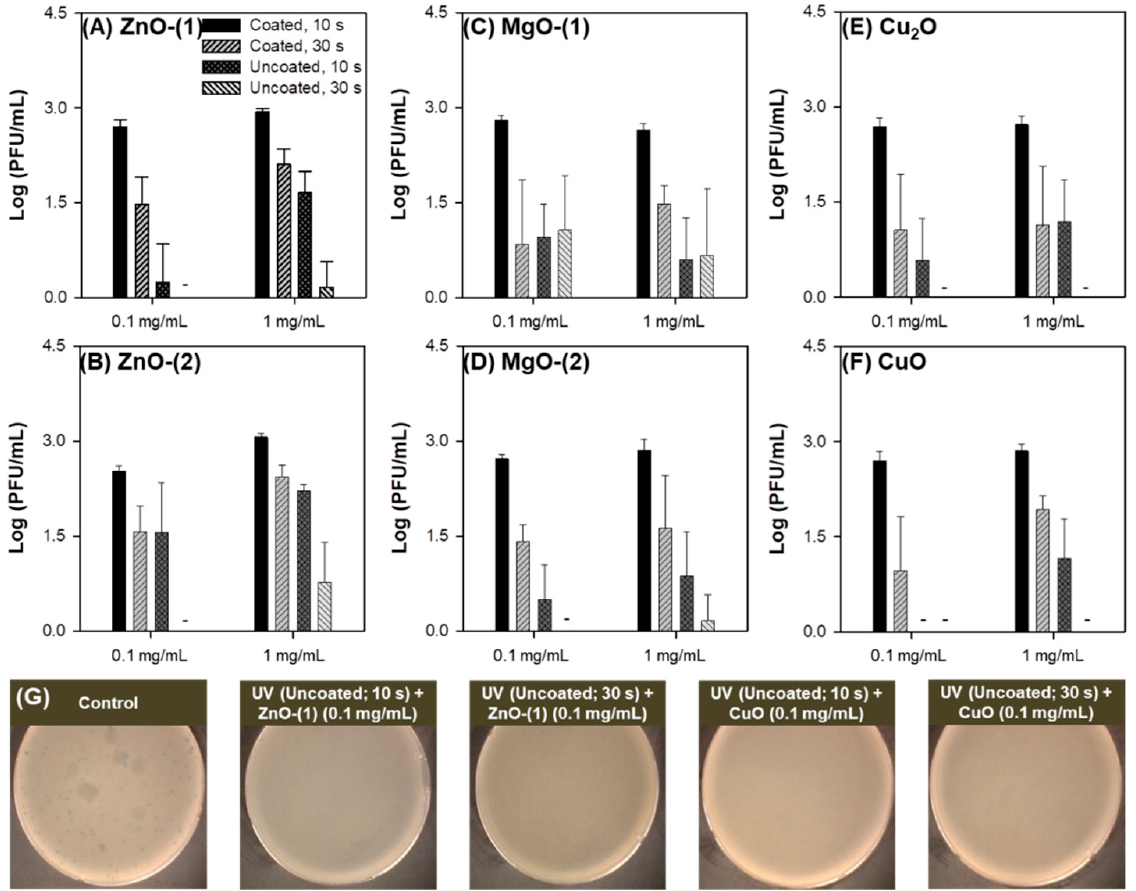
Figure 6. Antimicrobial effect of dual ultraviolet (UV)-metal oxide (MO) particle hybrids against phage: ( A ) ZnO-(1), ( B ) ZnO-(2), ( C ) MgO-(1), ( D ) MgO-(2), ( E ) Cu 2 O, and ( F ) CuO; ( G ) representative plate images of phage plaques. -, not detected.